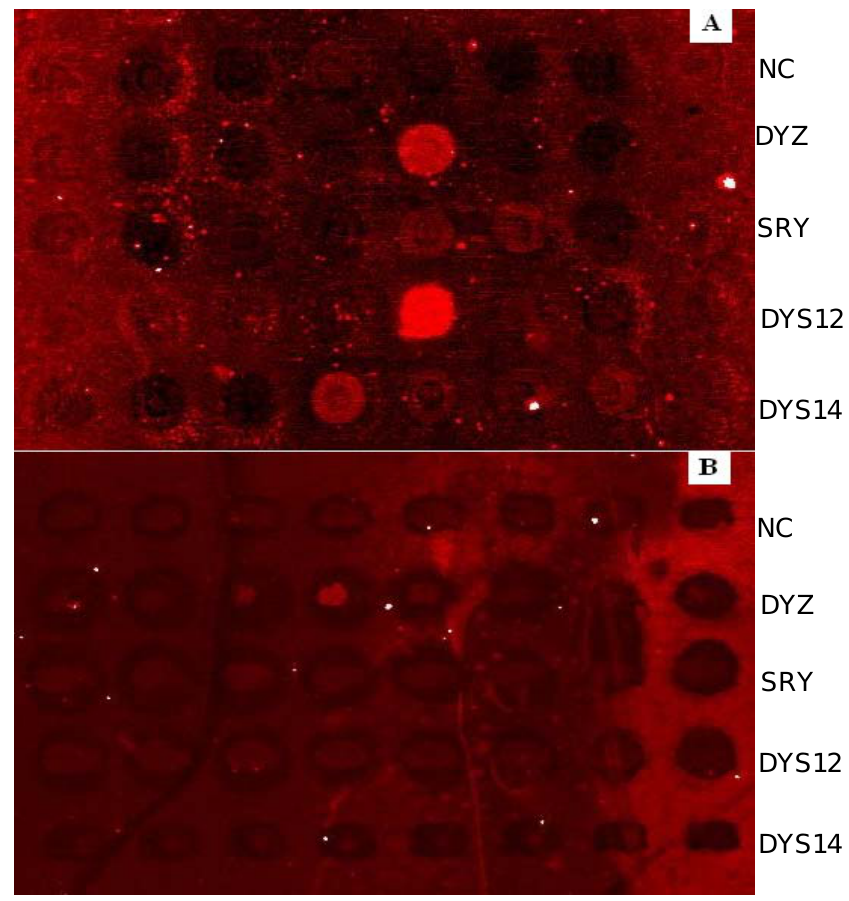
Figure 5. Comparing results of non-emulsion based on chip